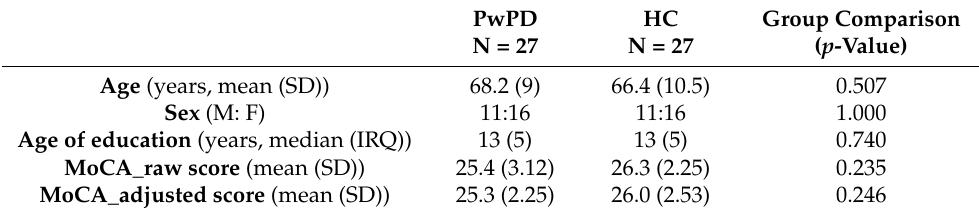
Table 2. Demographic and clinical characteristics of the whole sample.